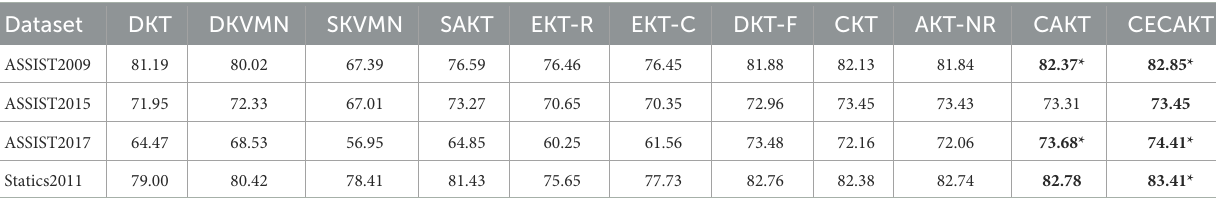
TABLE 3 The test AUC results (%) of all the